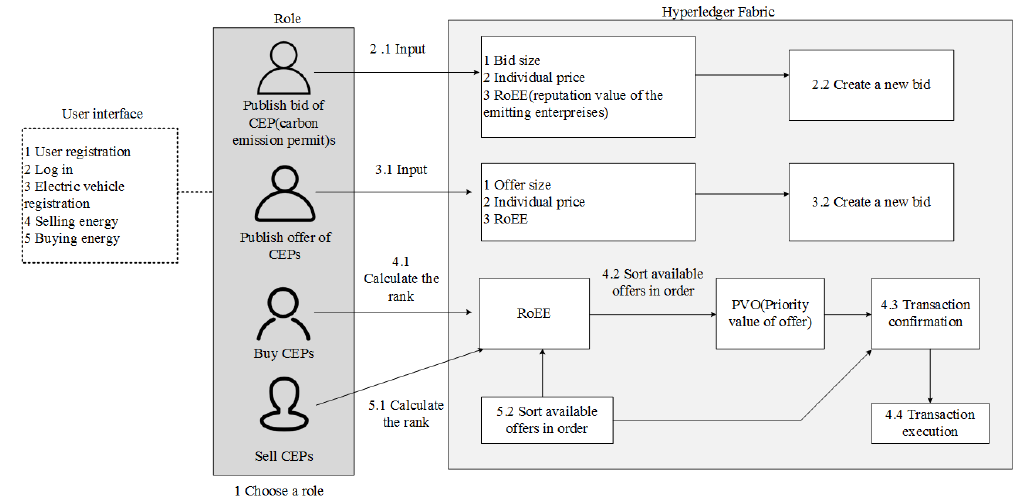
Figure 49. Reconstruction diagram of reference [83].